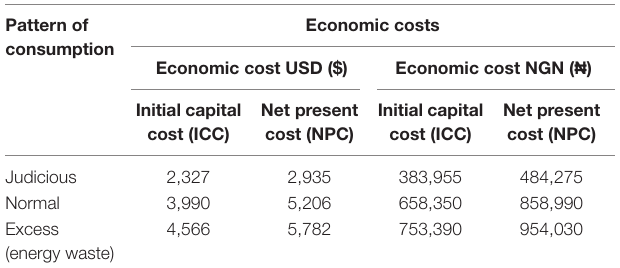
TaBle 5 | simulation results of economic costs (PV configuration with hoppecke battery).